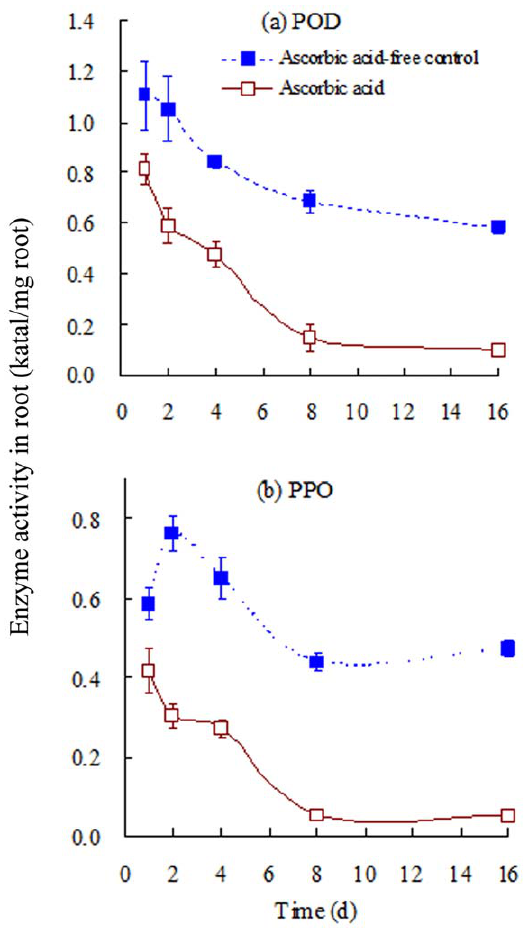
Figure 2. ( a ) POD and ( b ) PPO activities in the roots of tall fescue over time. The uptake time was defined as the time frame from the immersion of plant roots in solution containing phenanthrene to the removal of plant for extraction. Error bars represent standard deviation (SD). The initial phenanthrene concentration was 1.0 mg/L.